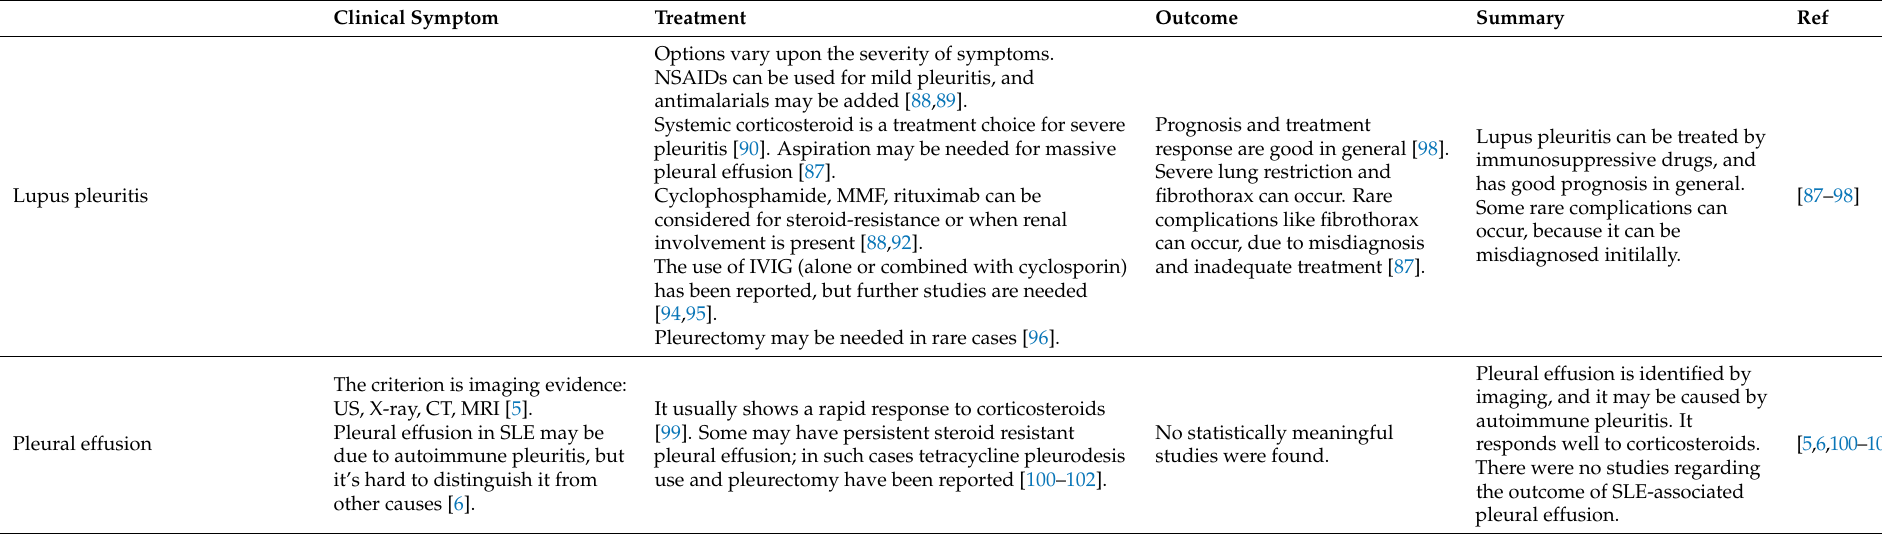
Table 3. Summary of the types of pulmonary involvement in